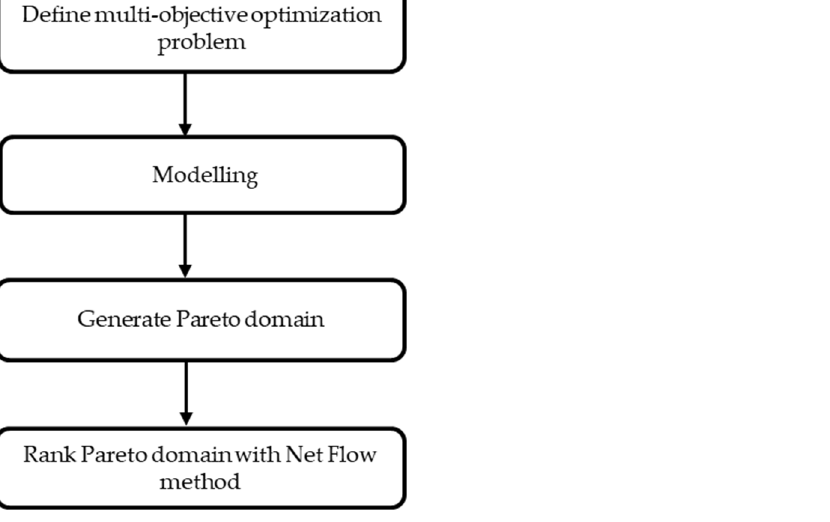
Figure 5. Flowchart of the methodology for solving the multi-objective optimization problem.